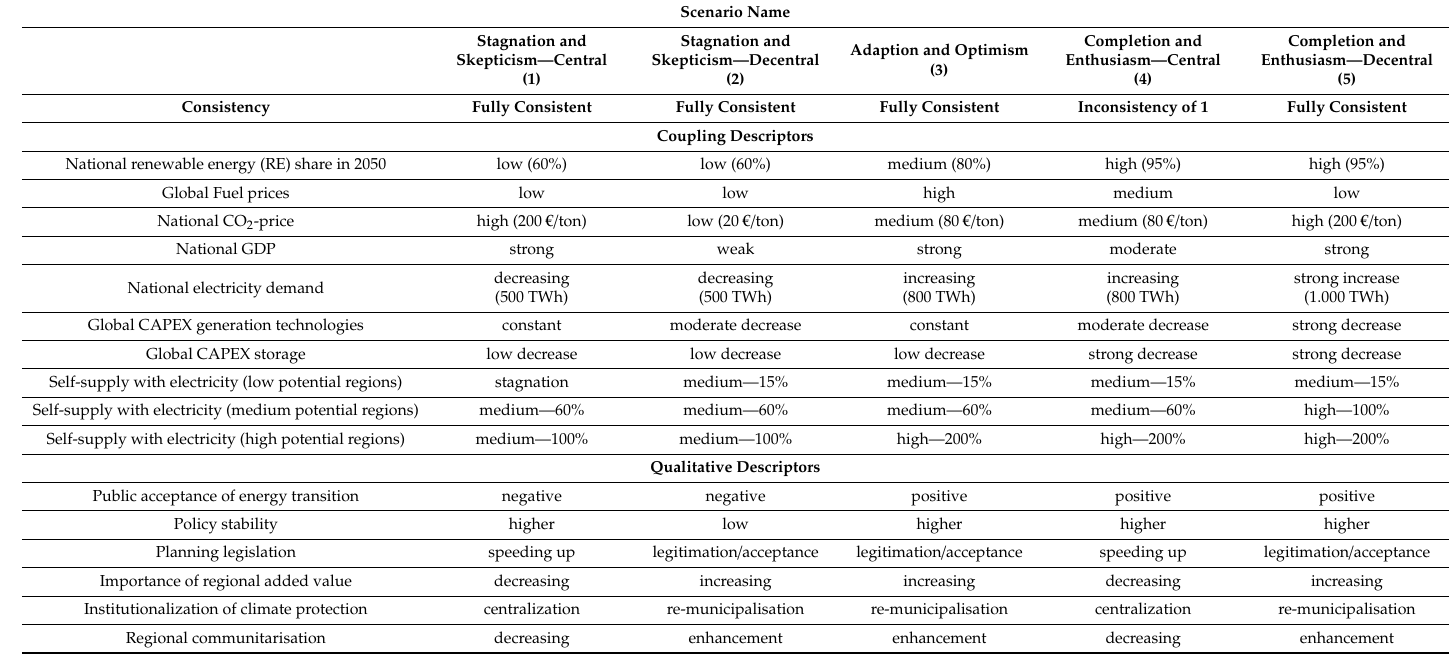
Table 1. The five selected plausible scenarios for